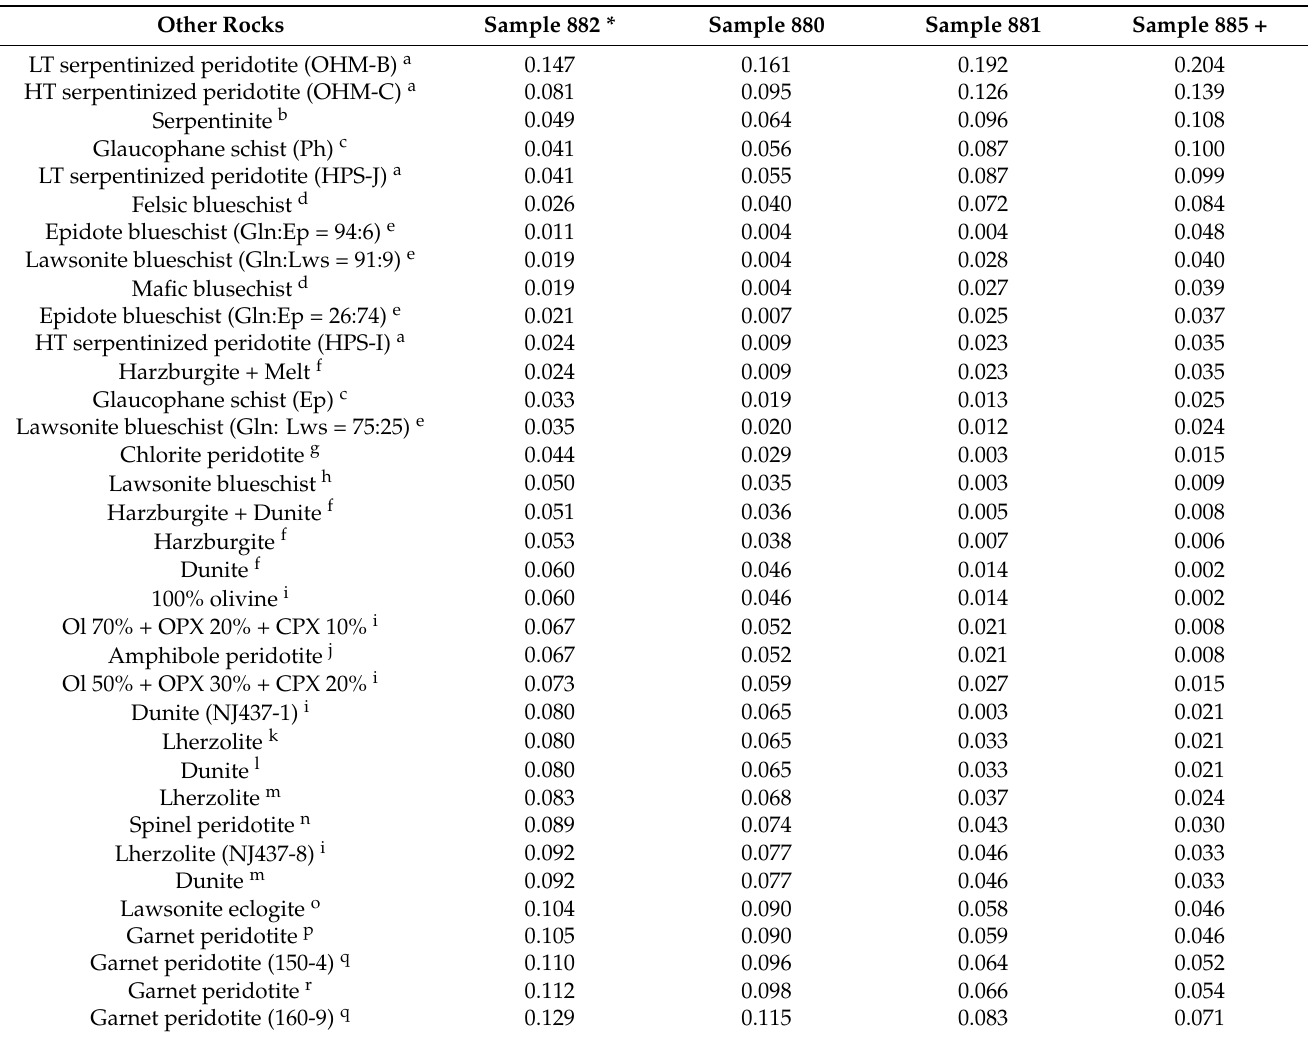
Table 5. Reflection coefficient (R C ) of the contact boundary between the studied eclogites and other rocks. Other